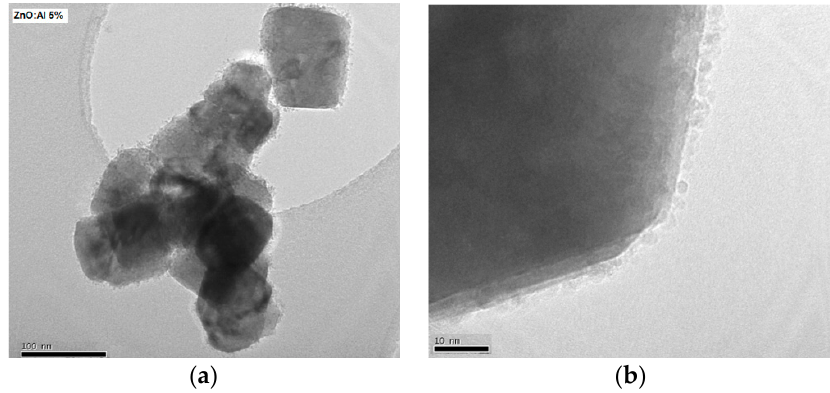
Figure 2. ( a ) Transmission electron microscopy (TEM) and ( b ) High Resolution TEM (HRTEM) images Figure 2. (a) Transmission electron microscopy (TEM) and (b) High Resolution TEM ( HRTEM) of Al-doped ZnO nanoparticles. images of Al-doped ZnO nanoparticles.